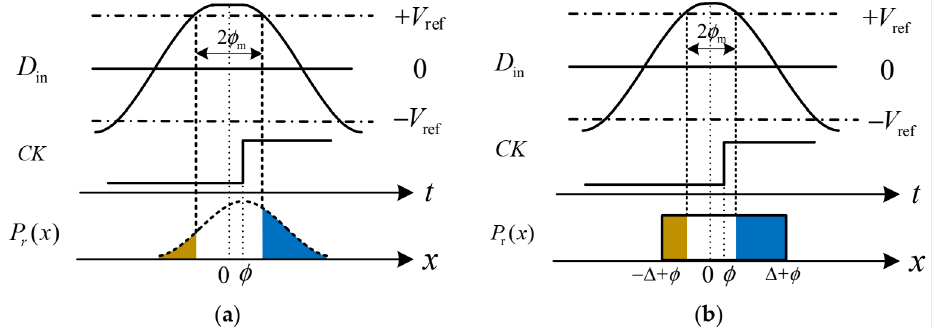
Figure 3. Smoothing of PD characteristic due to jitter. ( a ) Gaussian jitter and ( b ) uniform